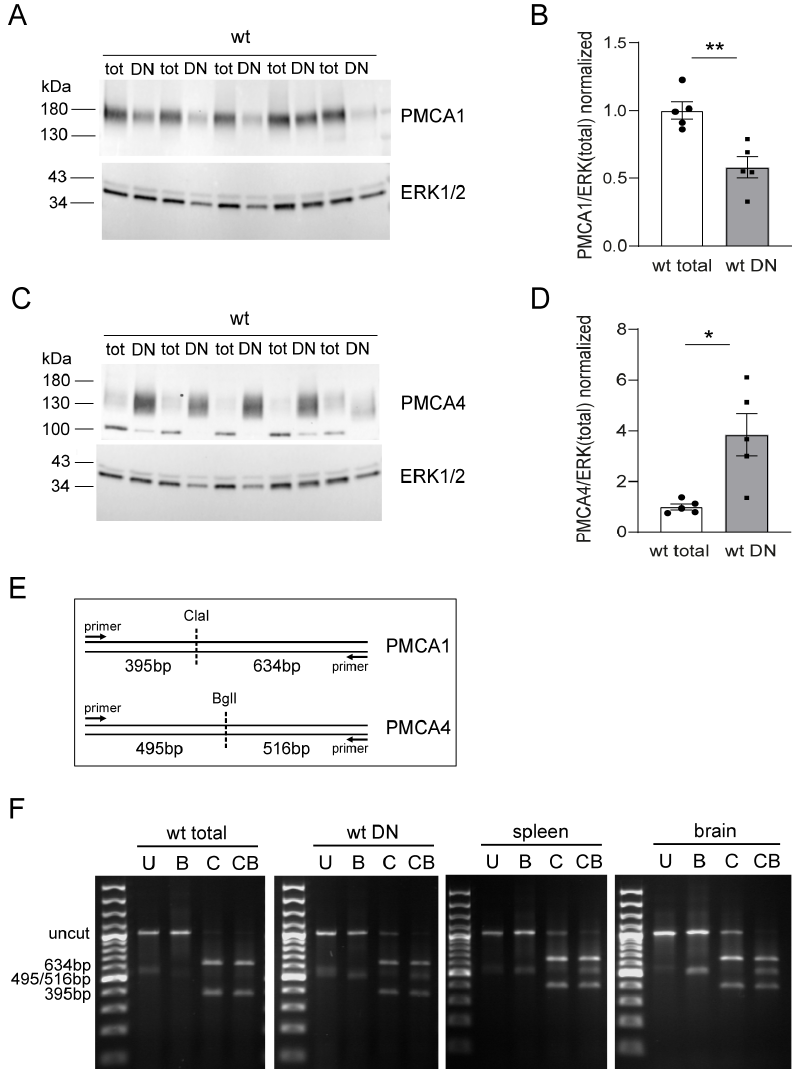
Figure 1. PMCA1 is the dominant PMCA isoform during T cell development. ( A – D ) Western blot analysis of PMCA1 ( A , B ) and PMCA4 ( C , D ) protein expression in lysates (15–30 µg/lane) from total thymocyte and DN thymocyte pellets obtained from 5 wildtype (wt) mice. ERK1/2 was used as the loading control. The molecular weight of PMCA1 appears higher than the expected weight of ~135 kDa, probably due to an unspecific aggregation. PMCA protein band intensities were quantified and divided by the respective ERK1/2 intensity. Bar graphs ( B , D ) show the mean relative protein level ± SEM normalized to the mean of total thymocytes. * p < 0.05, ** p < 0.01, by an unpaired Stu- dent’s t -test. ( E , F ) mRNA expression levels of Pmca1 and Pmca4 in total versus DN thymocytes by RT-PCR using a relative PCR strategy. (E) Scheme, depicting the size of fragments after a restriction digest of PCR products with ClaI (C), BglI (B), both (CB) or neither (U). ( F ) Representative agarose gels showing Pmca1 and Pmca4 specific restriction fragments in indicated thymocyte or control sam- ples. Mouse spleen and brain tissue served as controls. The image is representative of three inde- pendent biological samples.